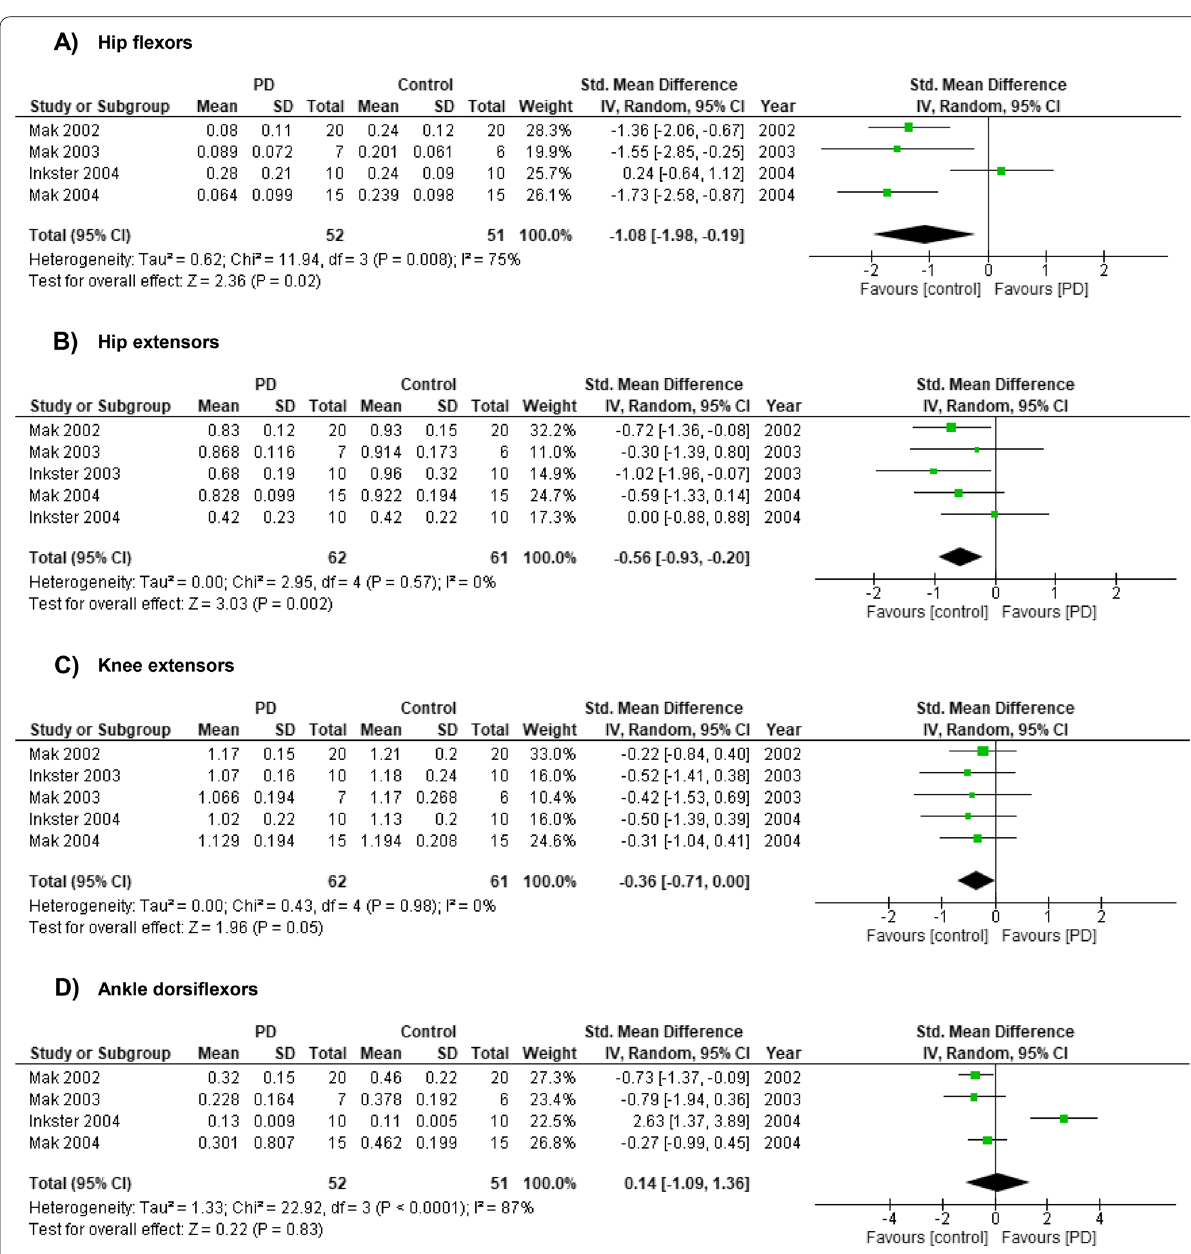
Fig. 3 Peak joint torques for four muscle groups: a hip flexors, b hip extensors, c knee extensors, and d ankle